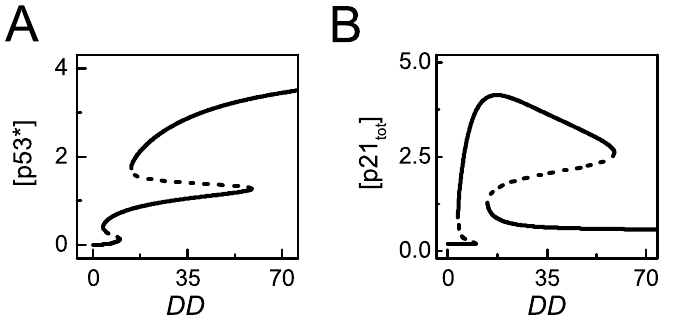
Figure 3. The steady-state behaviors of [p53 ∗ ] and [p21 tot ]. ( A , B ) Bifurcation diagram of [p53 ∗ ] ( A ) or [p21 tot ] ( B ) versus DD . The stable and unstable steady states are indicated by solid and dashed lines, respectively (the same